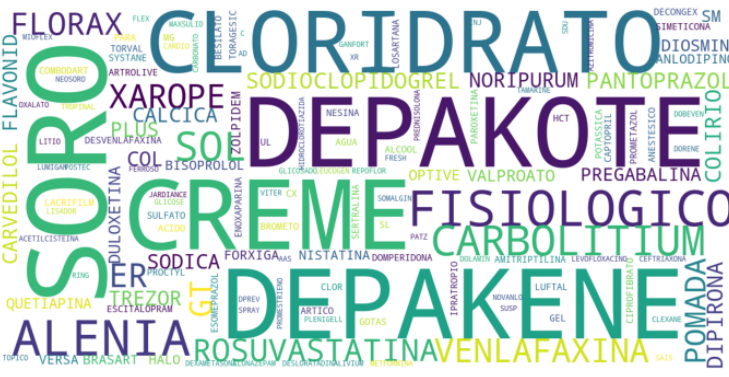
Figure 2. Word cloud of the extracted information.